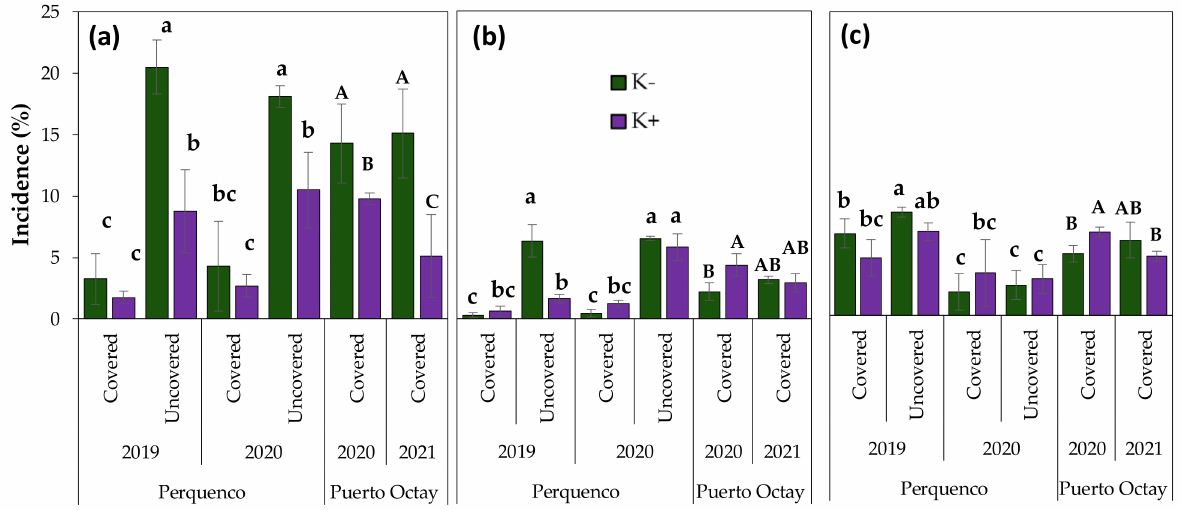
Figure 3. Incidence (%) of cracking ( a ), pedicel browning ( b ), and pitting ( c ) at harvest in fruits of sweet cherry (cv. Regina) cultivated at two orchards of southern Chile (Perquenco and Puerto Octay), subjected to two foliar potassium (K) treatments: conventional K regime (4 sprays during the season: K − treatment, white bars) or intensive K regime (7 sprays during the season; K+ treatment; black bars). In each location, the assays were conducted in two consecutive seasons. In the Perquenco orchard, covered and un-covered trees were compared. Different lowercase and uppercase letters above the error bars (standard deviation) indicate significant differences between the treatments in the Perquenco and Puerto Octay orchards, respectively, according to LSD Fisher multiple range test ( p ≤